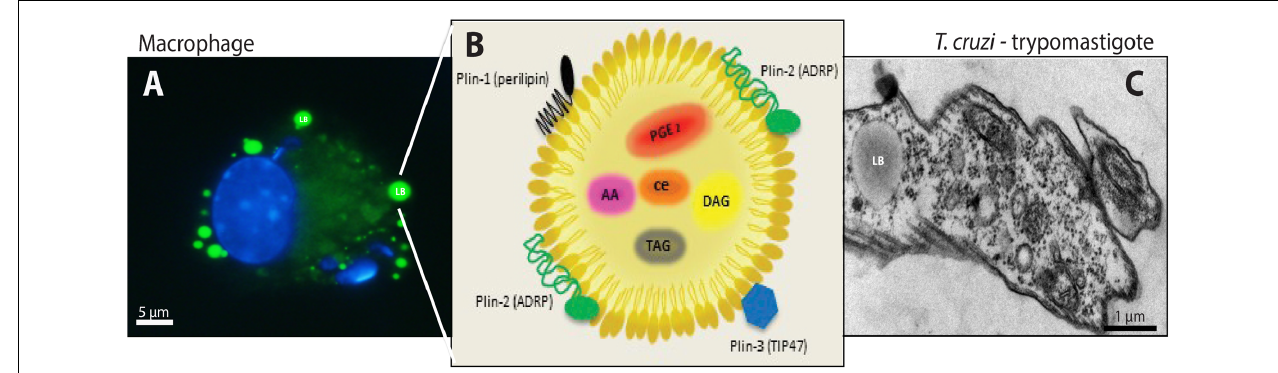
FIGURE 1 | Lipid bodies (LBs) biogenesis and components in both the host cell cytoplasm during the interaction and/or infection with T. cruzi and in the trypomastigotes forms of T. cruzi . (A) LBs accumulation (green) in murine infected macrophage after staining with BODIPY R (cid:13) 493/503. Nuclei of macrophage and internalized parasites were stained with DAPI (4 (cid:48) ,6-diamidino-2-phenylindole; blue). (B) Schematic representation of the structural composition of a LB. Colored objects represent LBs surface-bound proteins located in the phospholipid monolayer. Prostaglandin E2 (PGE) 2, arachidonic acid (AA), diacilclycerols (DAG), triacylglycerols (TAG), and cholesterol esters (CE) are found in the neutral lipid core. (C) Electron micrograph showing a LB in the trypomastigote form of T. cruzi . From: Melo, RCN (courtesy); Toledo, DAM and D’Avila, H.